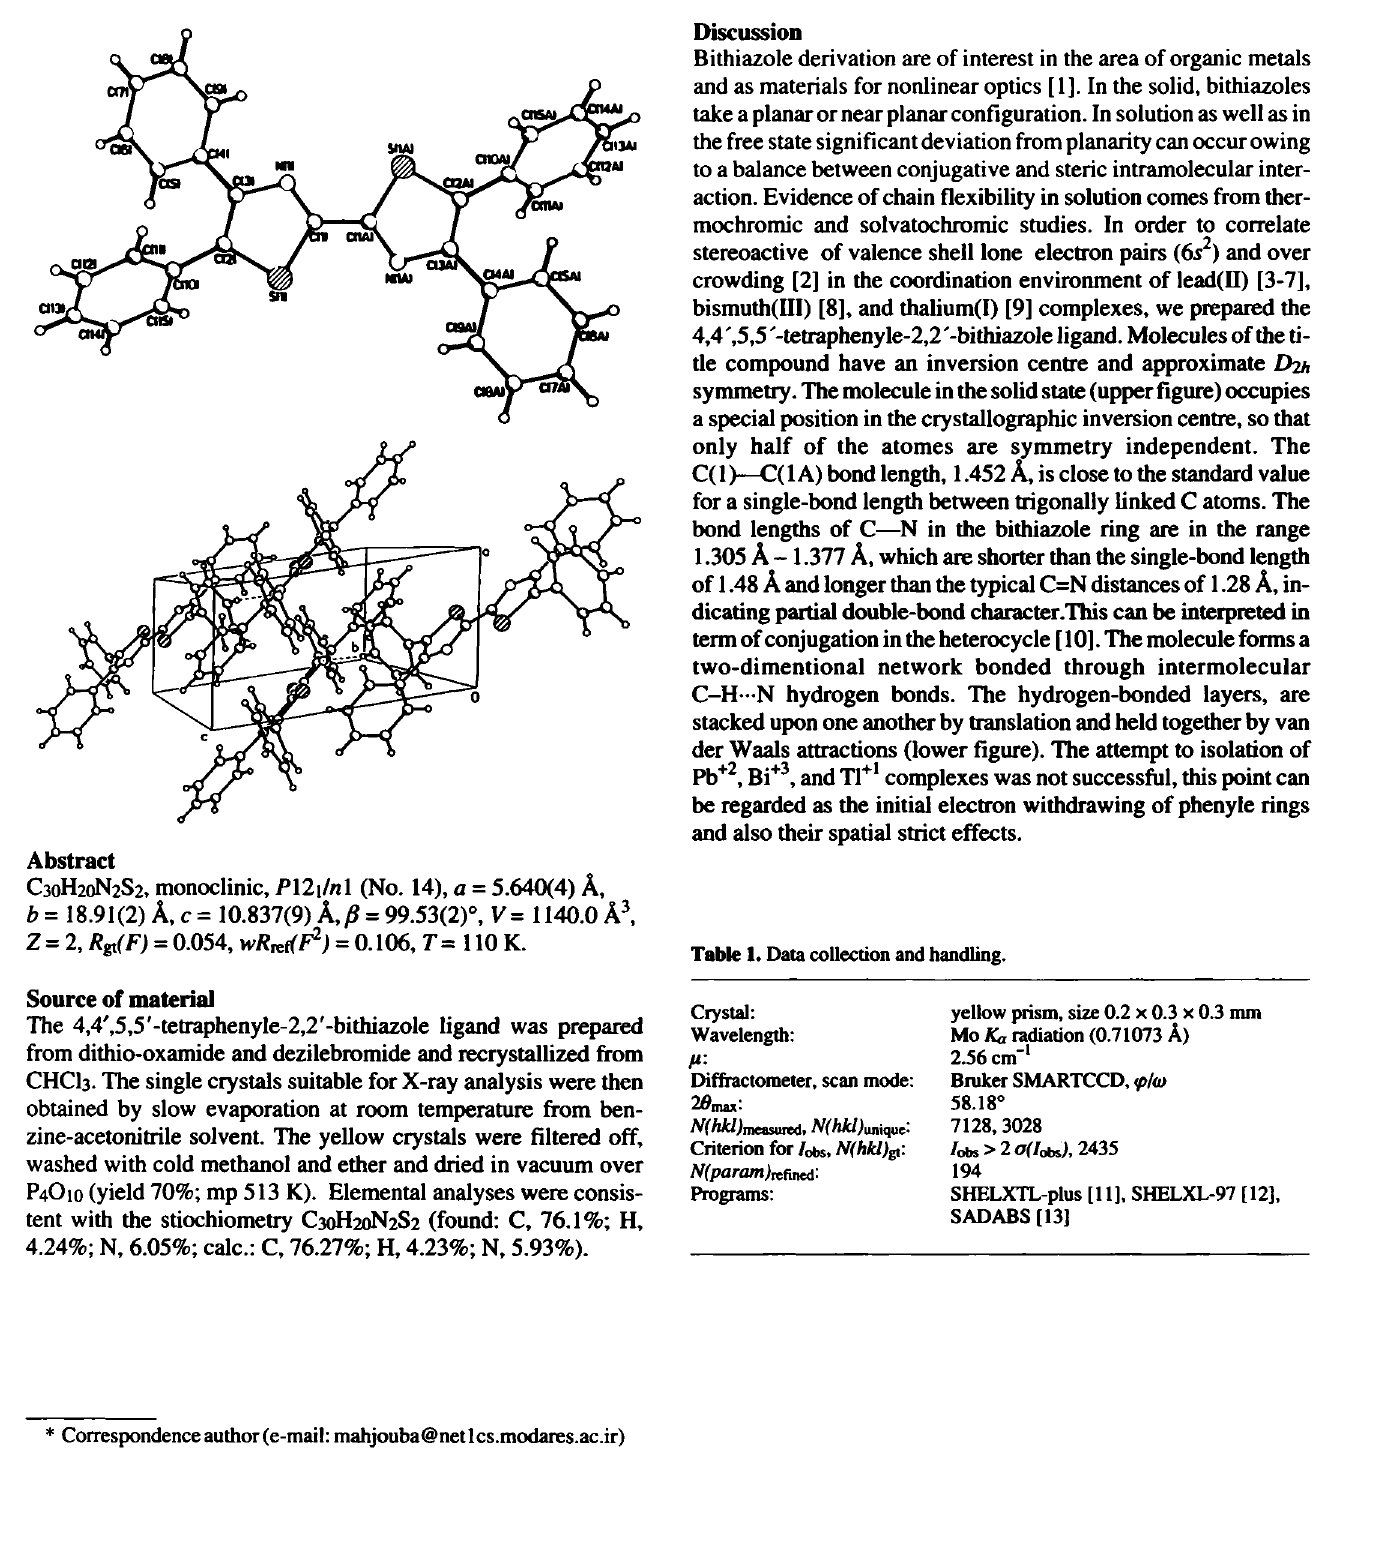
Table 1. Data collection and handling.